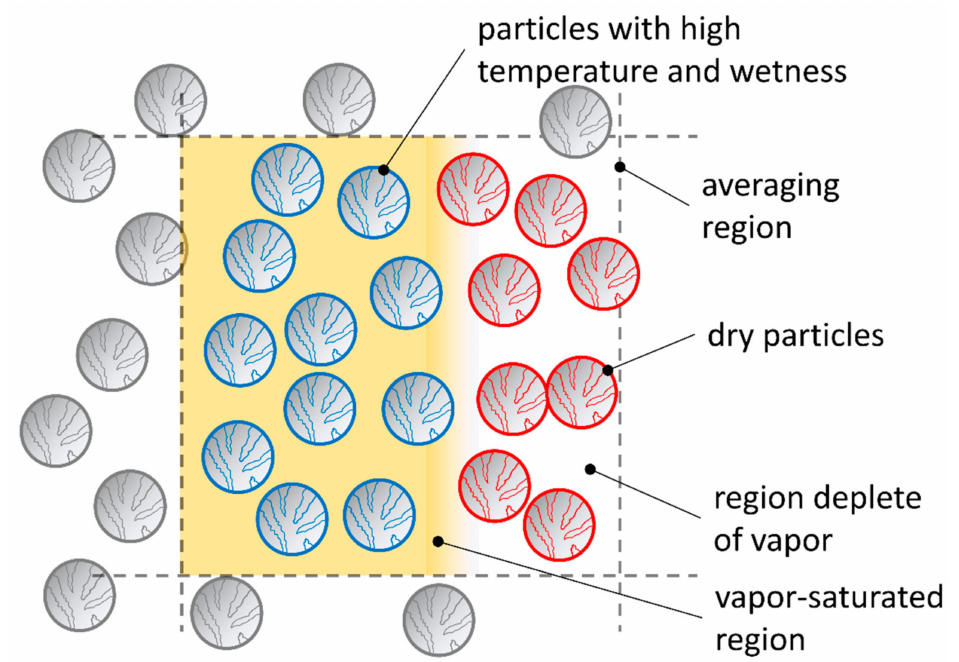
Figure 12. Importance of cell size in accurate estimation of the driving force based on the distribution of vapor inside the